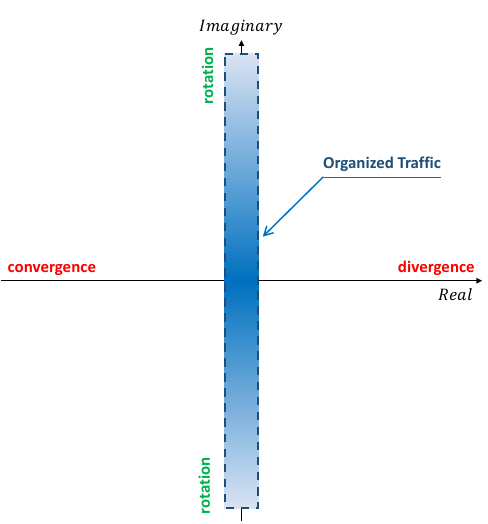
Figure 3. Impact of the eigenvalues of matrix A on the dynamics of the